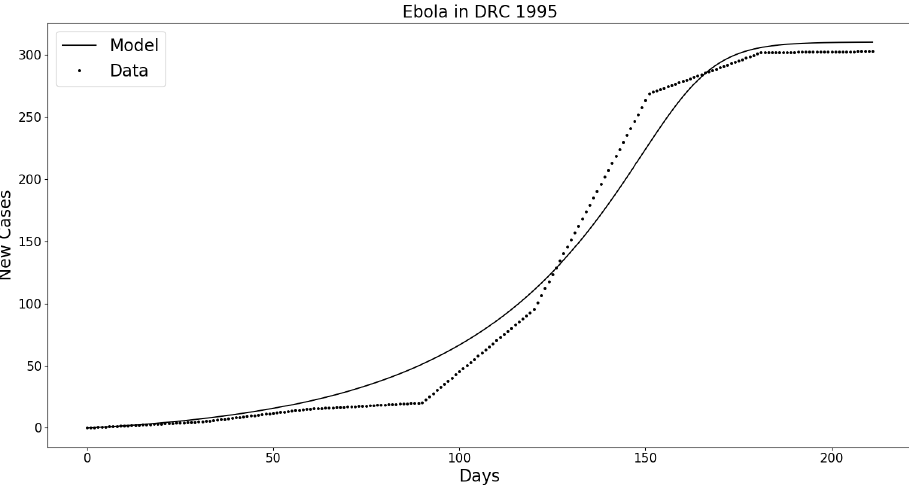
Figure A8. The horizontal axis represents the time in days and the vertical axis represents the cumulative number of new Ebola cases from the model simulations and actual data (data are from Figure 1 in [47]). The values of the parameters are as follows: N 0 = 8 millions, β I = 0.023 per day, t 0 = 164 days, n H = 20, and the values for the other parameters are as in Table 2. RE = 21.04% and R 0 =